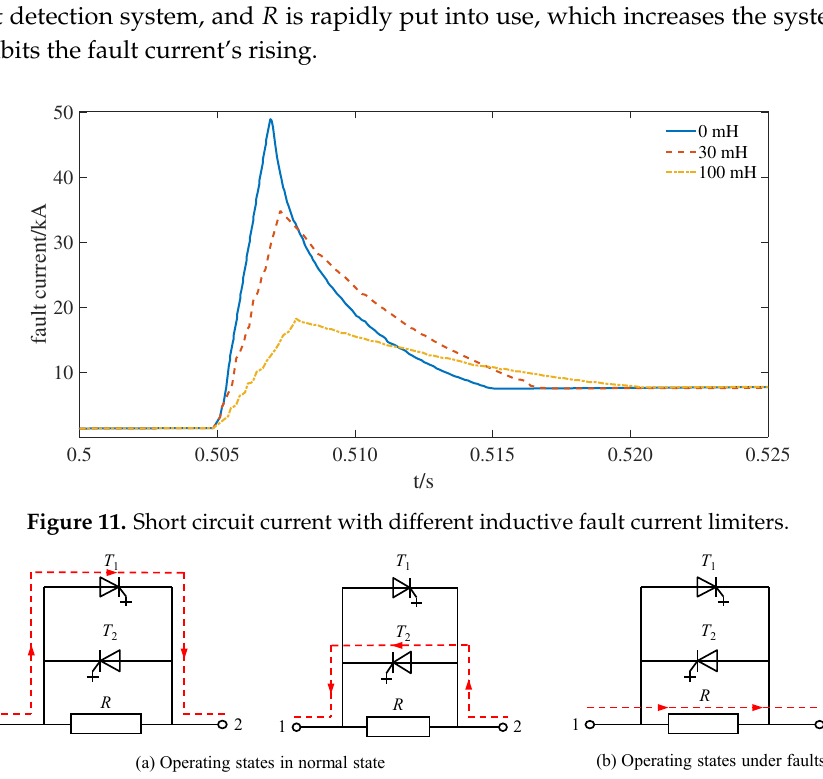
Figure 12. Operating states of resistive based solid-state fault current limiter (FCL).